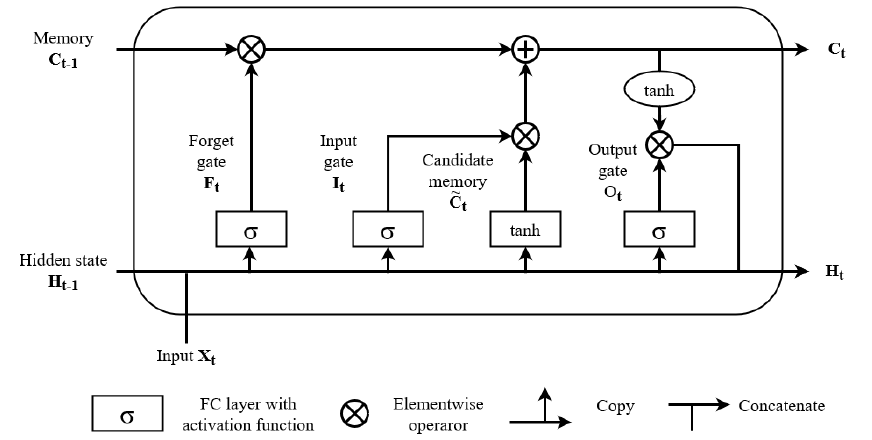
Figure 1. Architecture of Long Short Term Memory